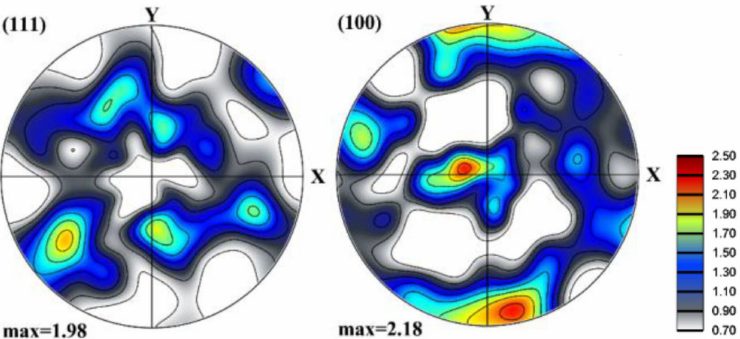
Figure 7. Texture of the 3D polycrystal with cube-type initial texture (discretized from a texture of an aluminum